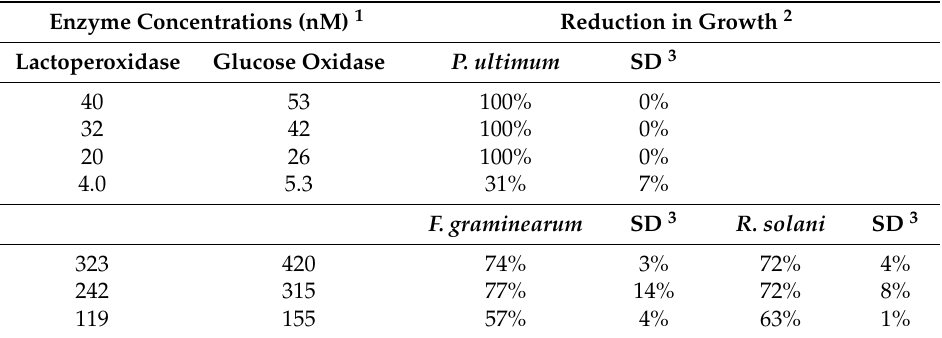
Table 1. Enzyme concentrations used to optimize formulations for in vitro experiments.